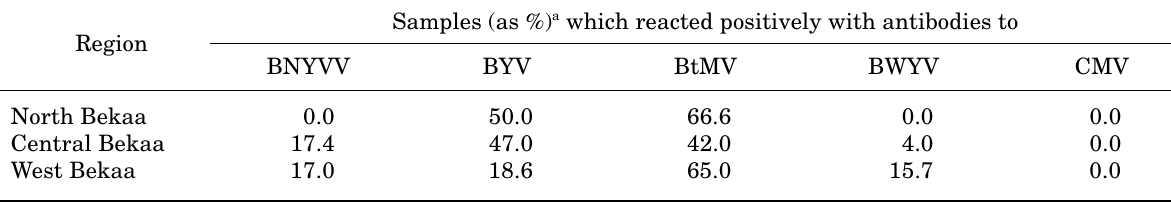
Table 2. Percent incidence of sugar beet viruses in three regions of the Bekaa valley.